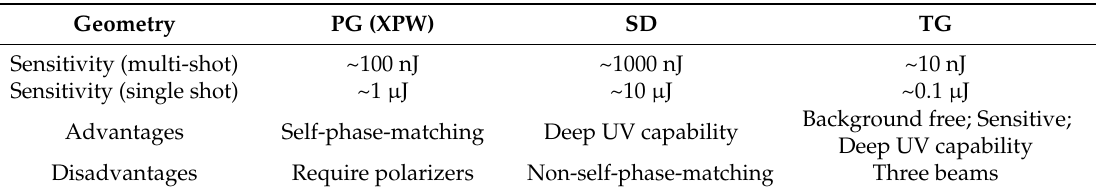
Figure 17. ( a ) Measured spectral interferometry obtained using TG-SRSI. ( b , d ) Measured SHG-FROG and TG-FROG time-frequency traces, respectively. ( c ) Reconstructed spectra (solid lines) and spectral phases (dash-dotted lines) obtained using TG-SRSI (black lines), SHG-FROG (red lines), and TG-FROG (blue lines), respectively [61]. Table 1. Comparison of XPW, SD, and TG processes [31].